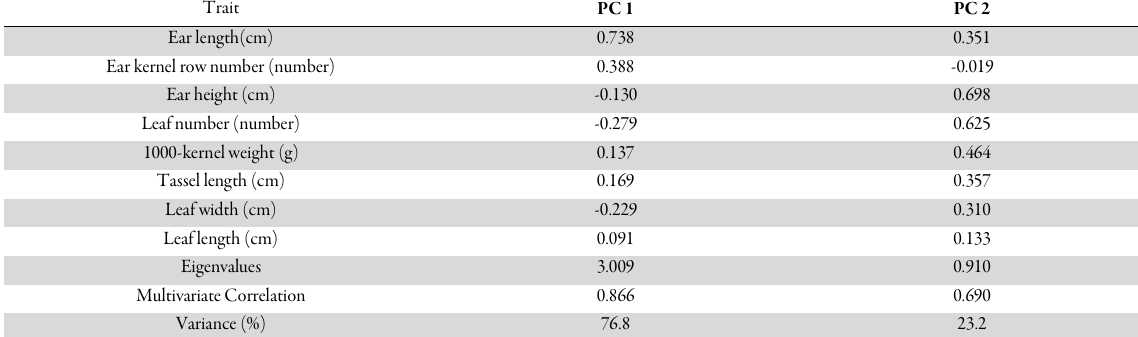
Table 5. Principal components analysis of 79 Turkish local genotypes evaluated in Ordu in 2015 using 8 agro-morphological traits Trait